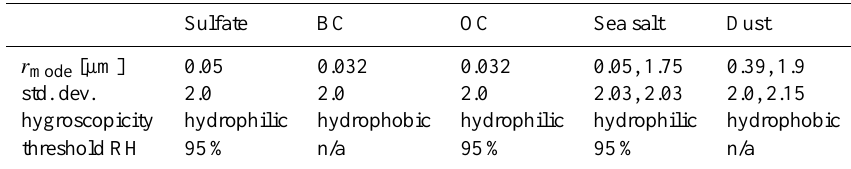
Table 1. Prescribed parameters of five major aerosols (sulfate, black carbon, organic carbon, sea salt and dust) for radiation calculations in CanAM4-PAM.